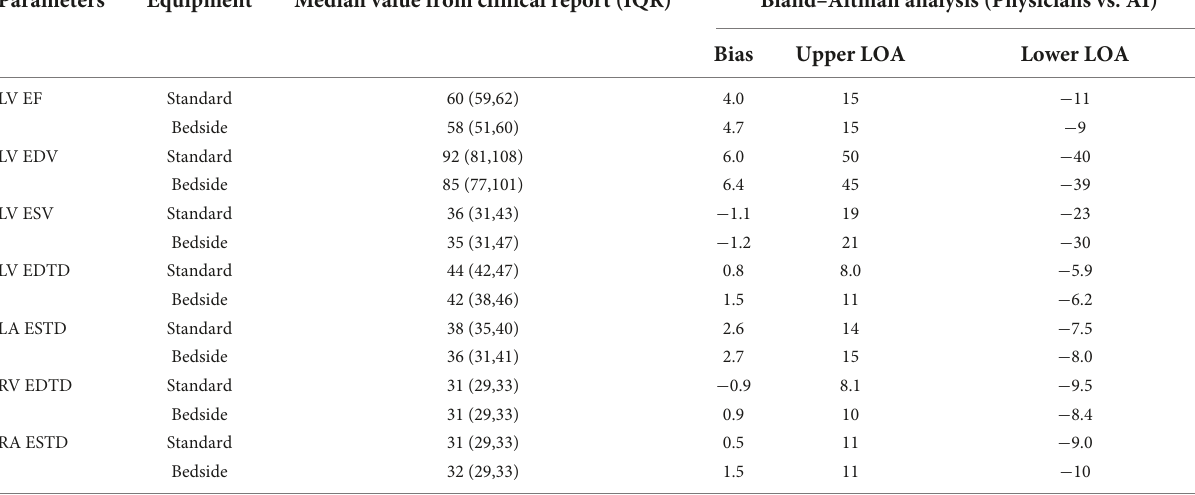
TABLE 4a The measurements of the corresponding clinical metrics for the RWMAs made by physicians and predicted by AI in internal test dataset. Parameters